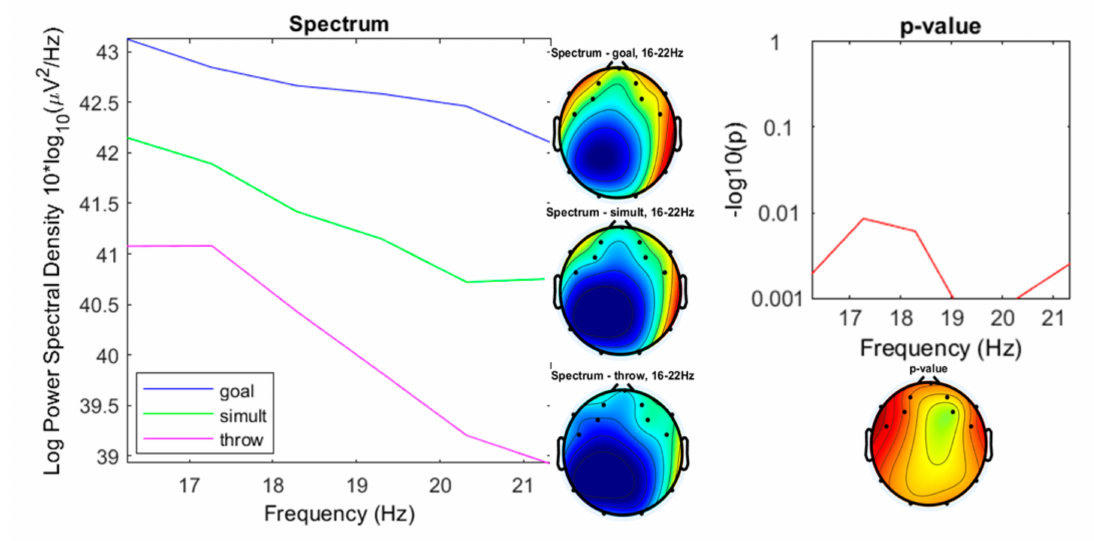
Figure 13. Spectrum plotting of the three conditions components (“throwing,” “goal,” “simultaneous”), with their plot averaged topography over frequency range, and the p -value plot for frequencies from16 to 22 Hz (mid-beta).